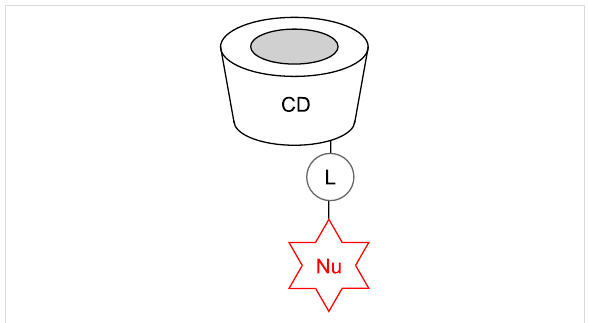
Figure 1: Schematic representation of the general structural design of the investigated cyclodextrin derivatives (CD = cyclodextrin ring, L = linking unit, Nu = reactive nucleophilic unit).